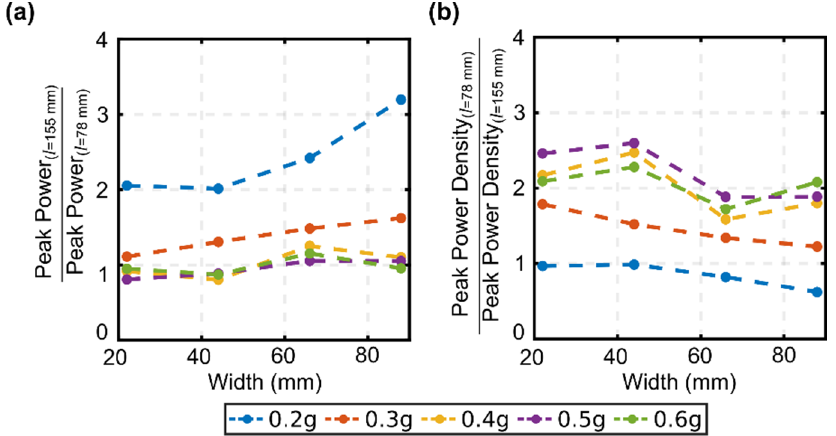
Figure 6. Relative performance of the two sets of harvesters across a common range of harvester widths; ( a ) peak power ratio of long to short harvesters; ( b ) peak power density ratio of short to long harvesters. Dashed lines between measurements are added to help visualize trends.